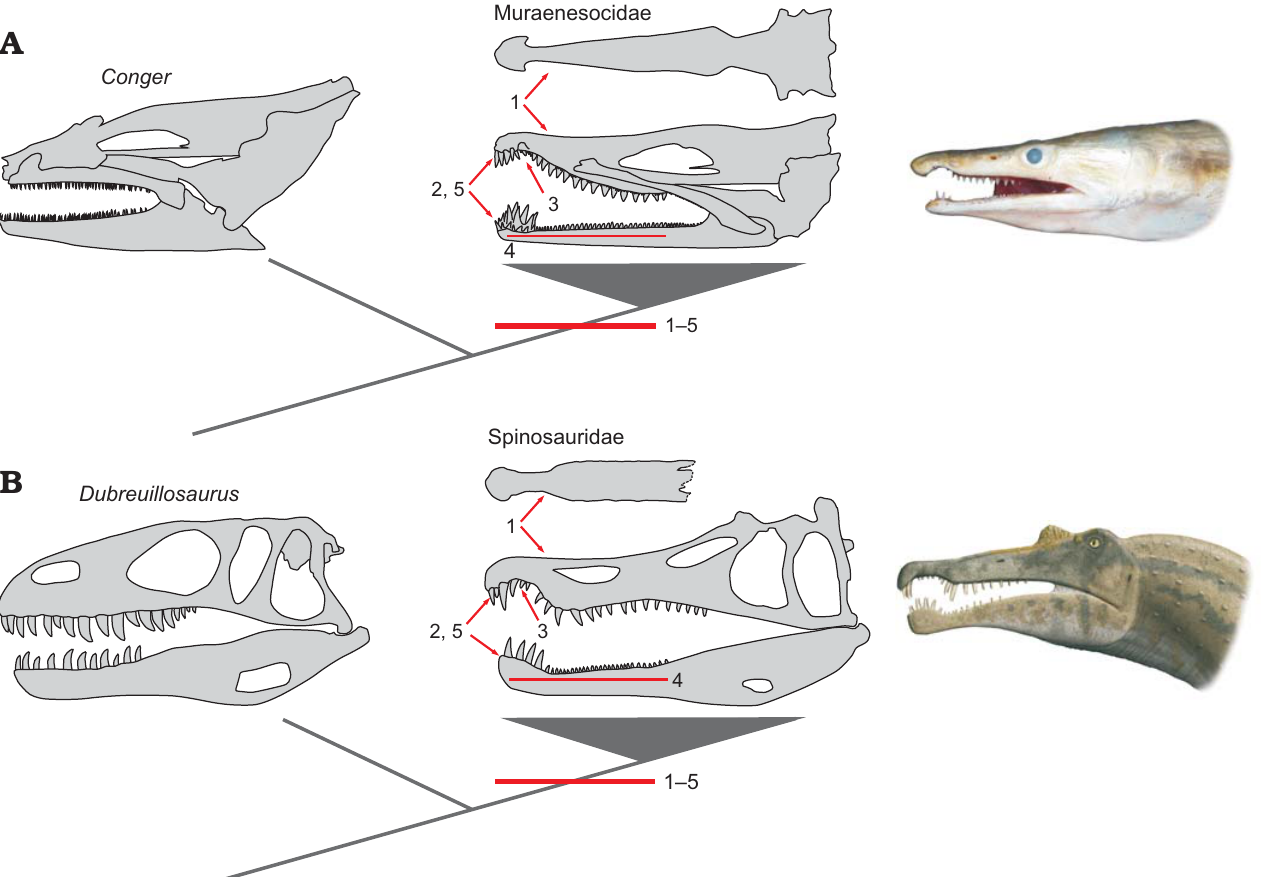
Fig. 1. Comparative evolution of jaws between Mura enesocidae ( A ) and Spinosauridae ( B ). Craniodental morphologies of Recent pike conger eels and Cretaceous spinosaurid theropod dinosaurs are convergently similar, likely resulting from similar feeding habits. In the sister groups of Muraenesocid- ae and Spinosauridae, here represented respectively by Conger (Congridae) and Dubreuillosaurus (Megalosauridae), skulls exhibit the plesiomorphic condition (i.e., rostrum not markedly elongated, absence of premaxillary and dentary “rosettes”, dentition homodont). The derived condition observed in both pike congers and spinosaurs, which seems to be associated with an enhanced sensitivity, can be interpreted as an adaptation to forage efficiently in aquatic environments and to grab evasive prey items such as fishes. Mura enesocidae are represented here by Muraenesox bagio (skull and head), and Spinosauridae by Baryonyx walkeri (skull) and Spinosaurus aegyptiacus (head reconstruction; courtesy of Stephen O’Connor). Characters: 1, elongated rostrum; 2, terminal “rosette” in both upper and lower jaws; 3, deep notch posterior to the upper jaw “rosette”; 4, strong heterodonty (in size); 5, “rosettes” bearing enlarged teeth. Illustrations not to